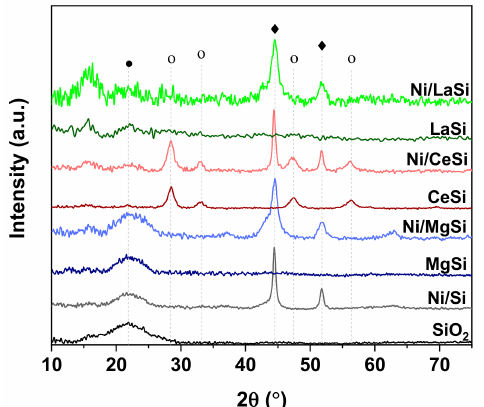
Figure 2. XRD patterns of the Ni/Oxide-SiO 2 catalysts—( • ) peak corresponds to SiO 2 ; (o) peaks correspond to CeO 2 ; ( (cid:7) ) peaks correspond to